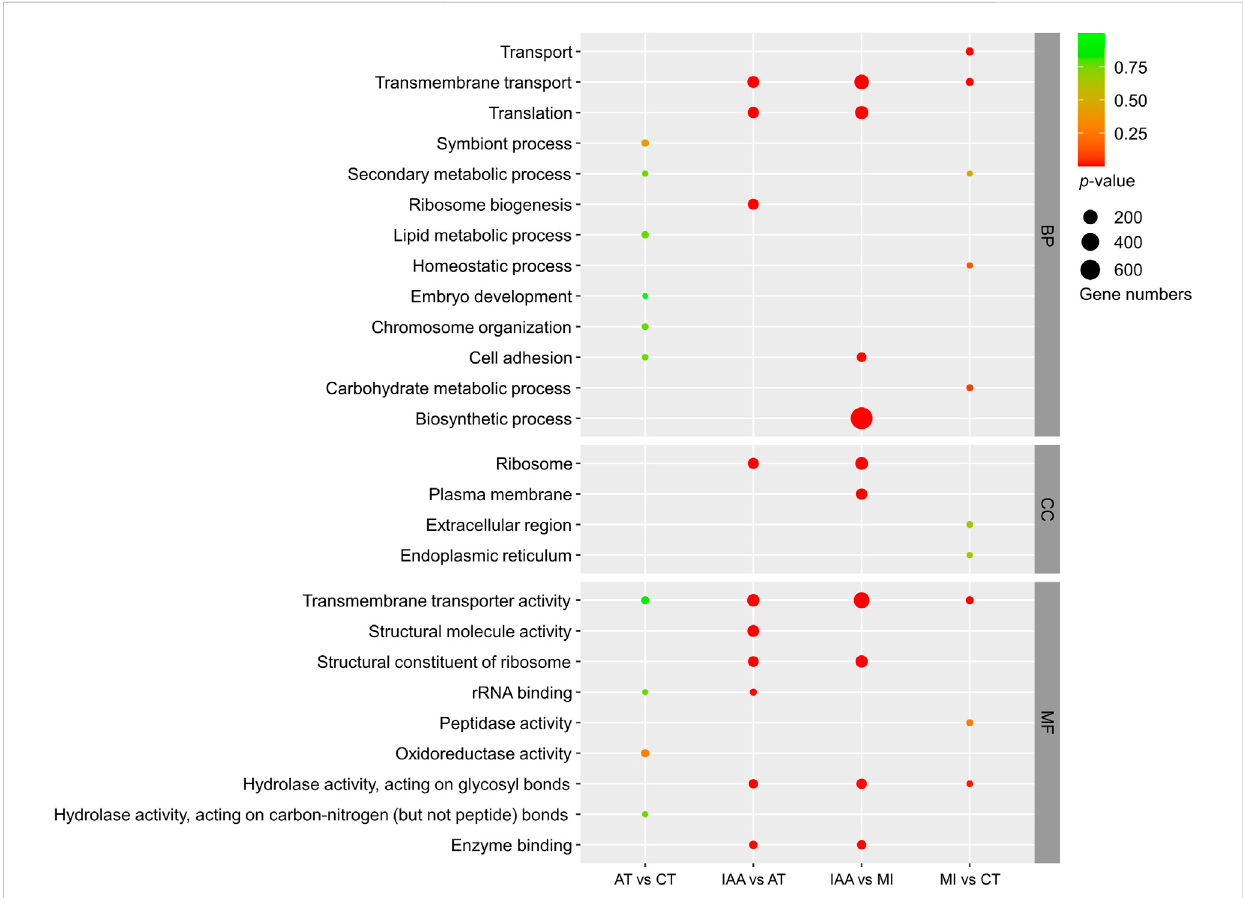
FIGURE 5 GO enrichment of DEGs identi fi ed in each comparison group. The size of the dot indicates the number of genes, and the p -value was derived by hypergeometric tests. BP: Biological Process; CC: Cellular Component; MF: Molecular